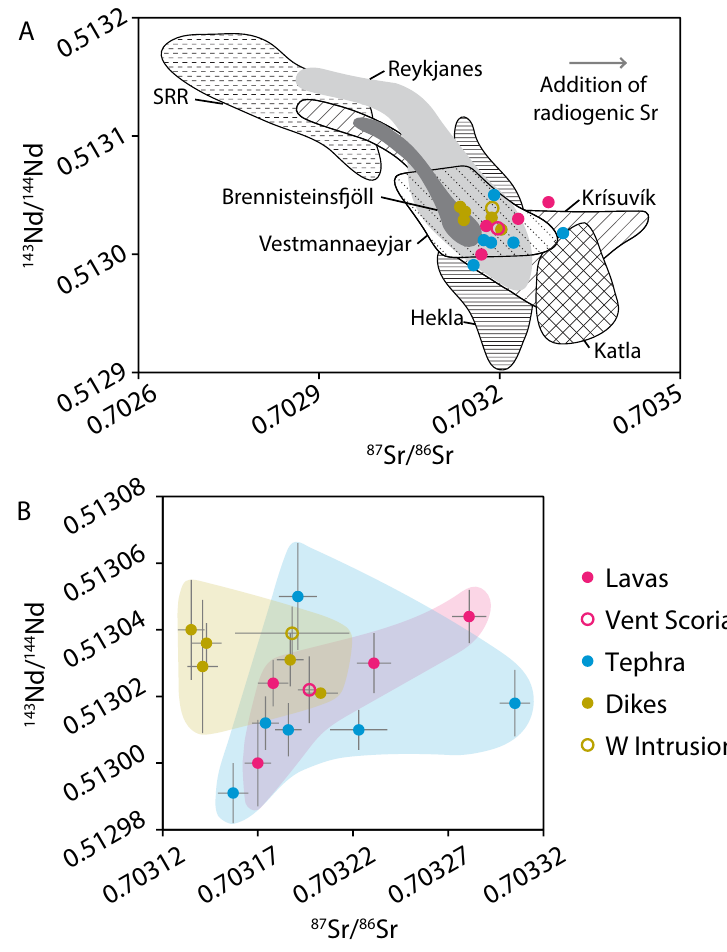
Figure 12: [A] Sr-Nd isotope ratios Thríhnúk- agígur samples are compared to the Southern Reykjanes Ridge (SRR) and several volcanic systems in southern Iceland [Park 1990; Fur- man et al. 1991; Sigmarsson et al. 1992; Fur- man et al. 1995; Thirlwall et al. 2004; Kok- felt 2006; Peate et al. 2009]. They greatly expand the range of values for Brennisteins- fjöll and occupy the more enriched end of the observed Reykjanes Peninsula